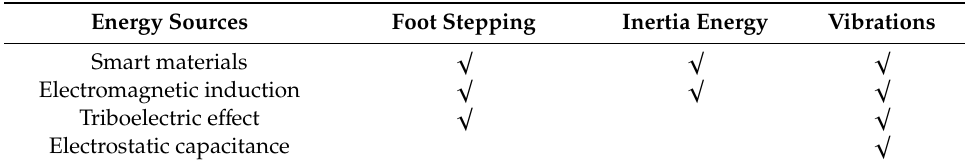
Table 1. Optional ways to capture available energy